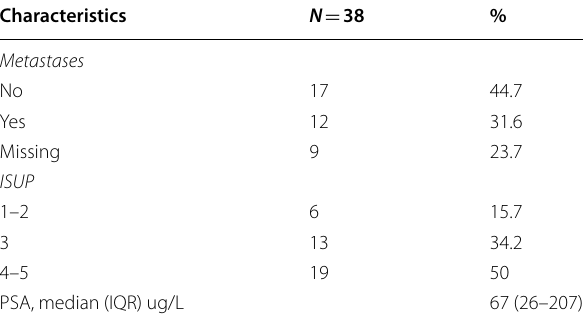
Table 3 Tumor factors of prostate cancer cases Table 6 Differences between the classic metabolic syndrome